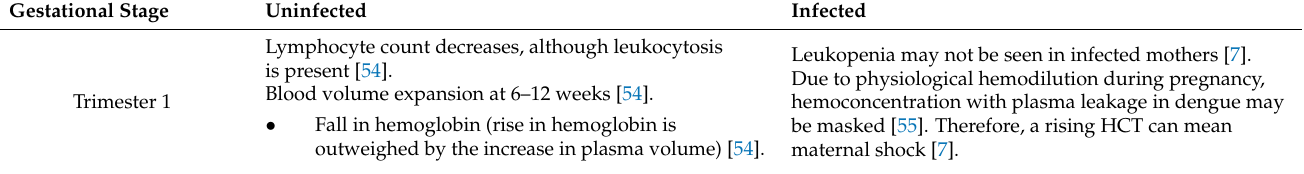
Table 3. Uninfected versus dengue-infected hematological changes in pregnant